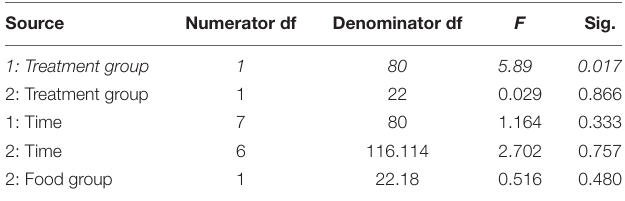
TABLE 2 | Fixed effects from the linear mixed effects model of lean mass in study 1 (indicated by 1) and study 2 (2) between treatment groups, food groups and across time.